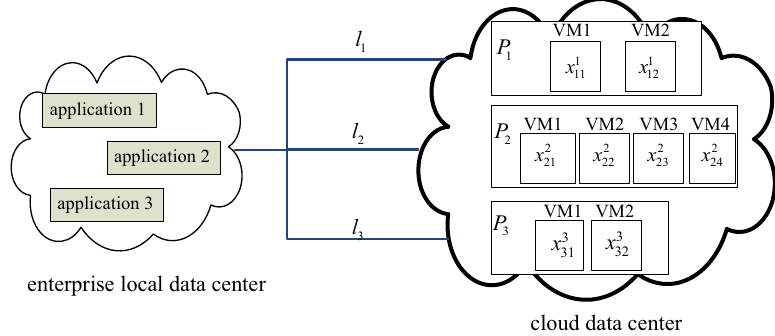
Figure 4. An example of enterprise applications migration and deployment into cloud